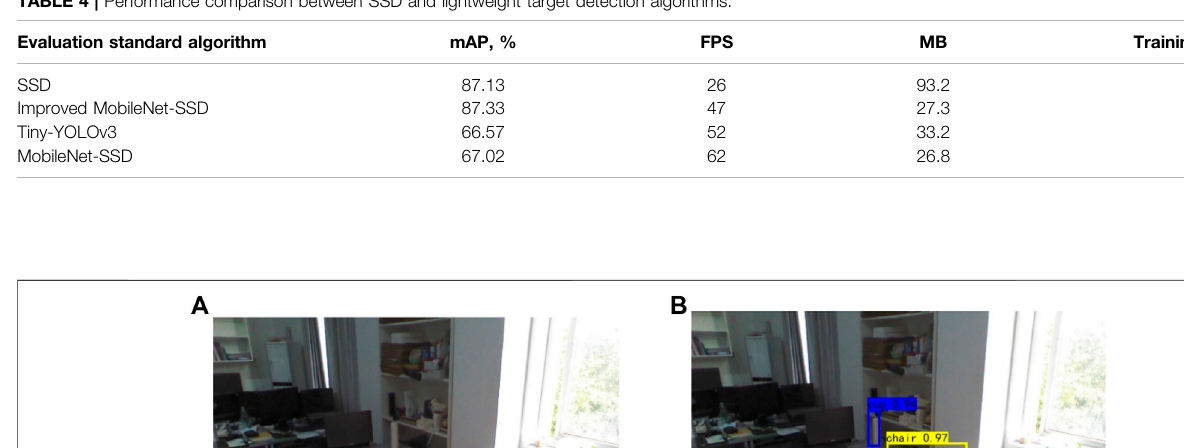
TABLE 4 | Performance comparison between SSD and lightweight target detection algorithms.